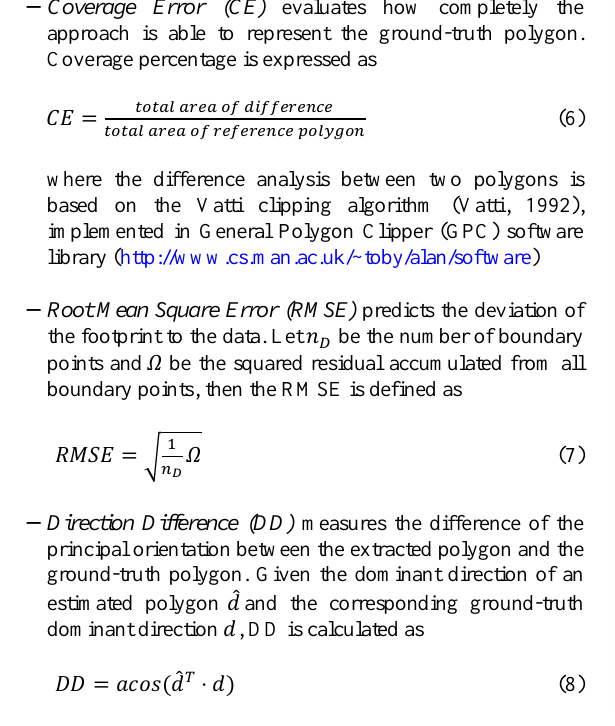
Figure 7. Comparison of performance under various Gaussian noise